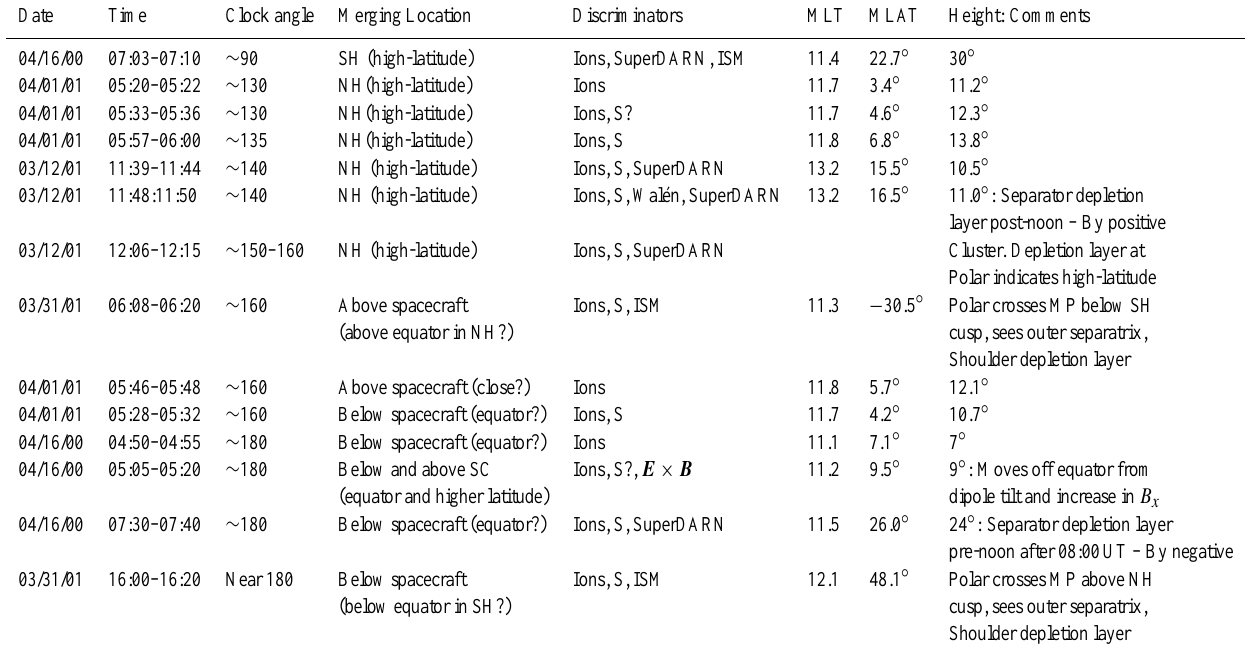
Table 1. On the location of merging with varying clock